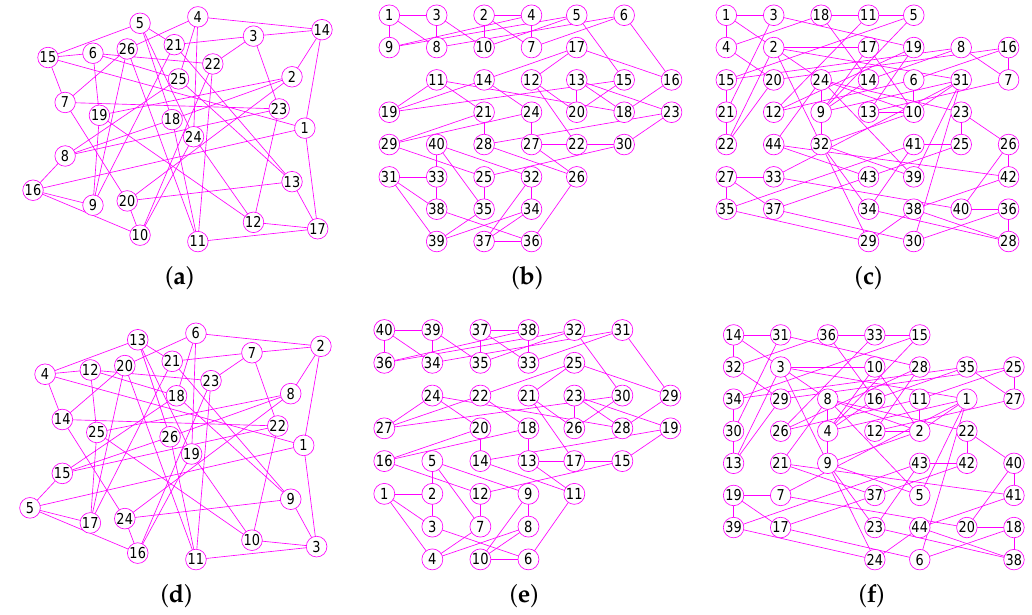
Figure 23. The TopMost graphs of three graphs G 40 , G 41 and G 42 . ( a ) The projective plane graph G 40 of 26 vertices and 52 edges; ( b ) The Miyazaki graph G 41 with 40 nodes and 60 edges; ( c ) The Cubic Hypohamiltonian graph G 42 of 44 vertices and 75 edges; ( d ) The TopMost graph of G 40 ; ( e ) The TopMost graph of G 41 ; ( f ) The TopMost graph of G 42